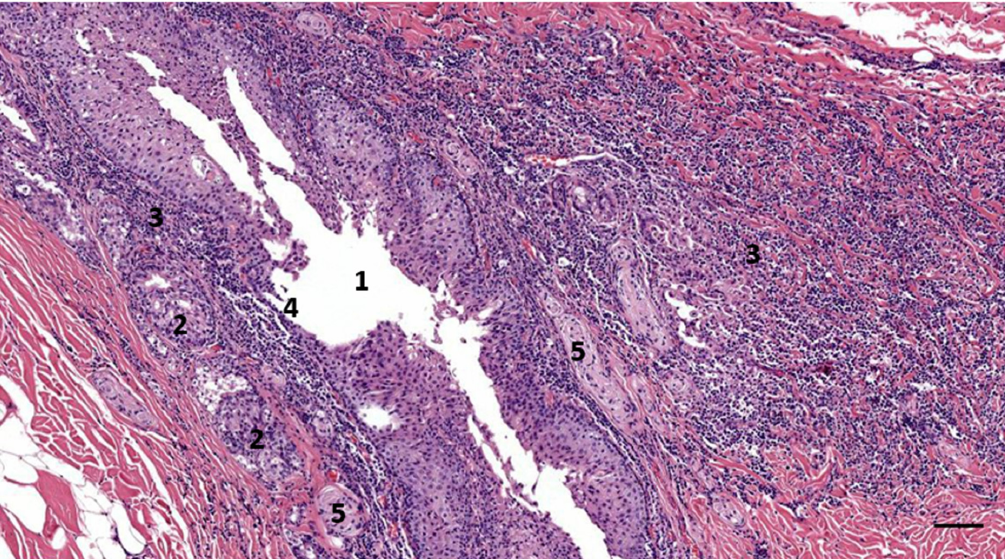
Figure A2. A histological image (HE staining) of an oblique section through the external ear canal (1) of a striped dolphin (293/18) at the level of the ventral curvature of the canal and glands (2). Note the intense circummeatal presence of inflammatory cells (3) with ulceration of the epithelium (4), and the presence of lamellar corpuscles (5). Scale bar = 100 µ